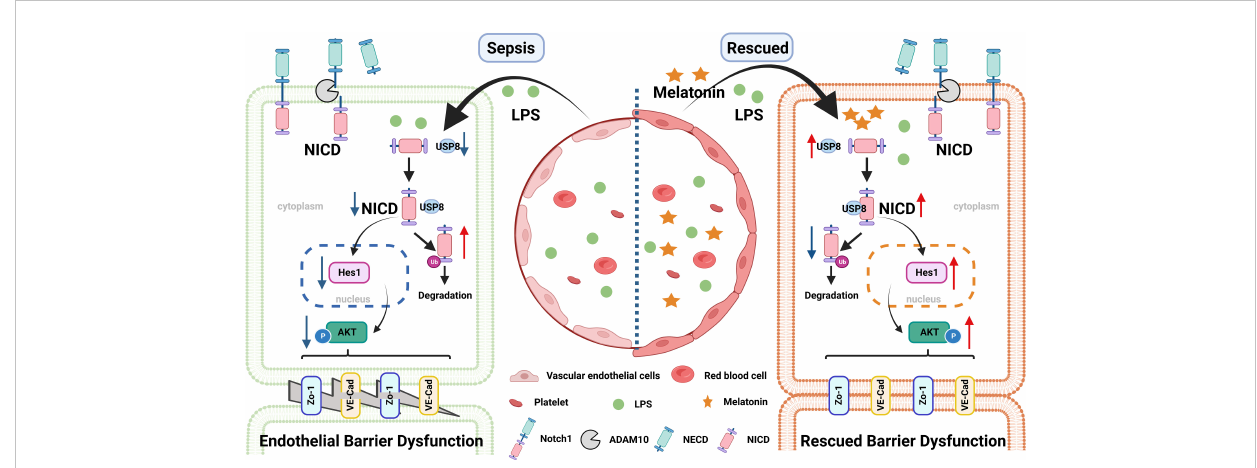
FIGURE 8 A pattern schematic created with BioRender. LPS promotes the ubiquitination of NICD by downregulating the level of USP8 to induce endothelial cell dysfunction in sepsis, which is rescued by